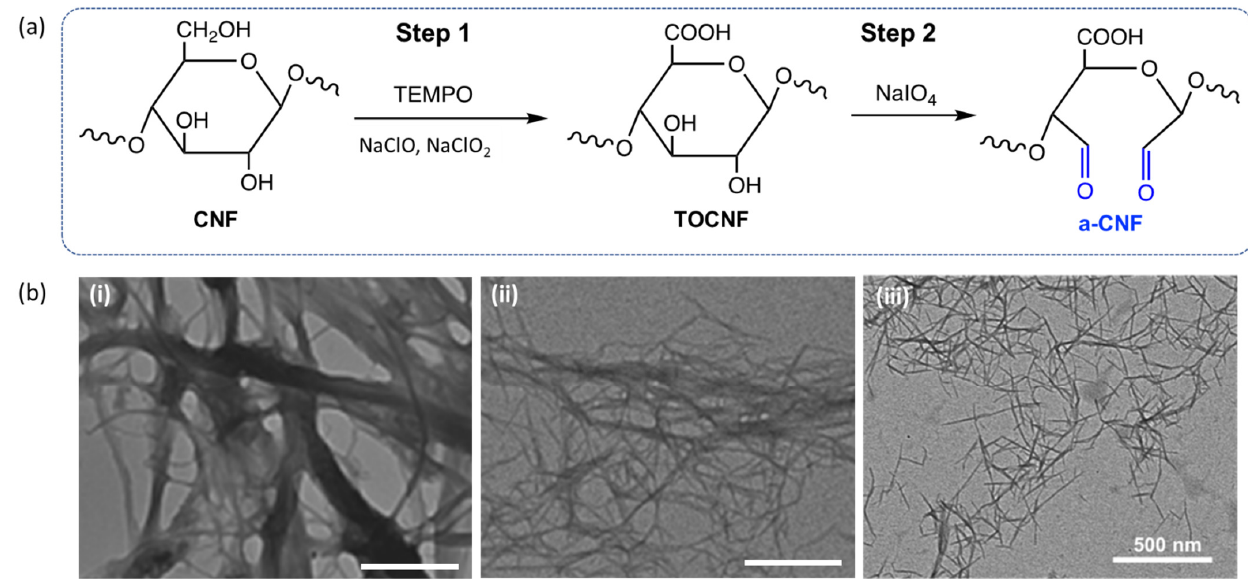
Figure 1. Surface modification of CNFs. ( a ) Schematic of two-step modification of CNFs with car- boxyl groups (Step 1) and aldehyde groups (Step 2). ( b ) TEM images of pristine CNFs (i), TOCNFs (ii) and a-CNFs (iii). Scale bars are 500